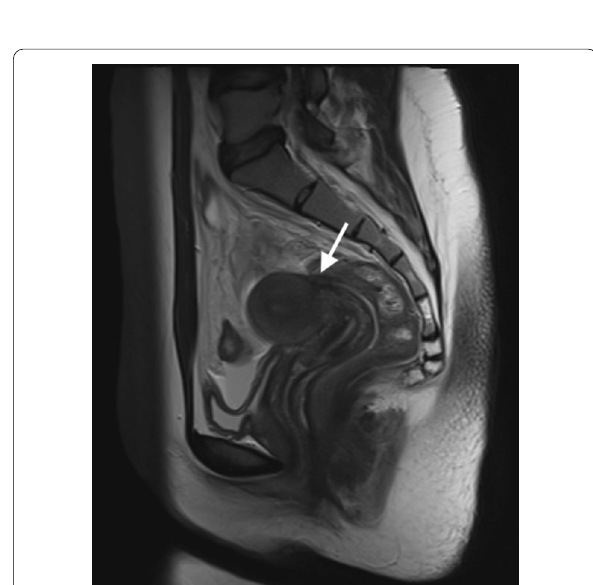
Fig. 4 T2 weighted sagittal MRI image showed involvement of Torus-Uterinus as a single site of